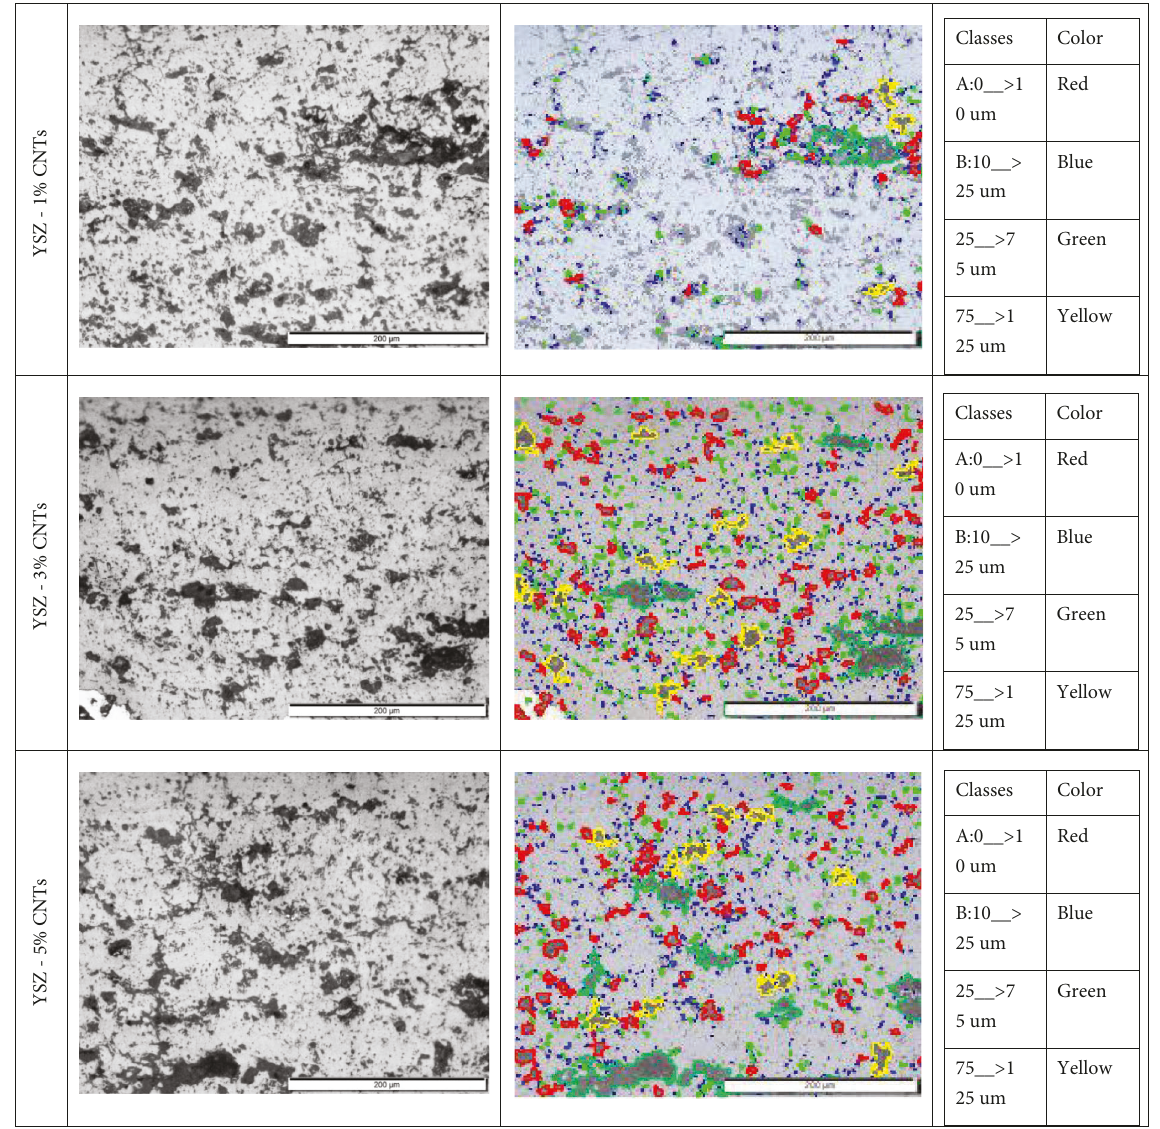
Figure 3: Optical image of YSZ with three different CNT proportion indicating the dispersion at higher